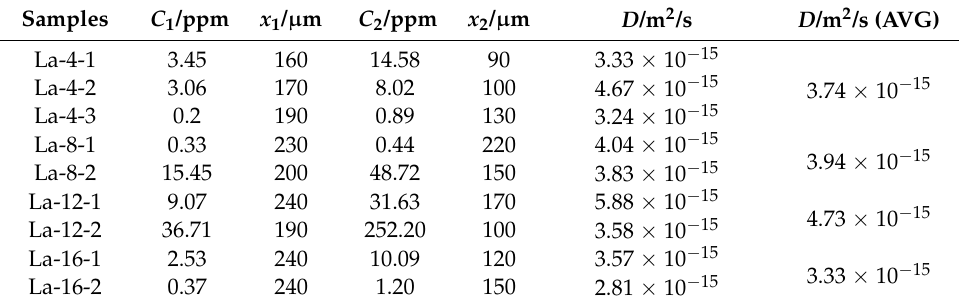
Table 2. Diffusion coefficient of La in apatite (400 ◦